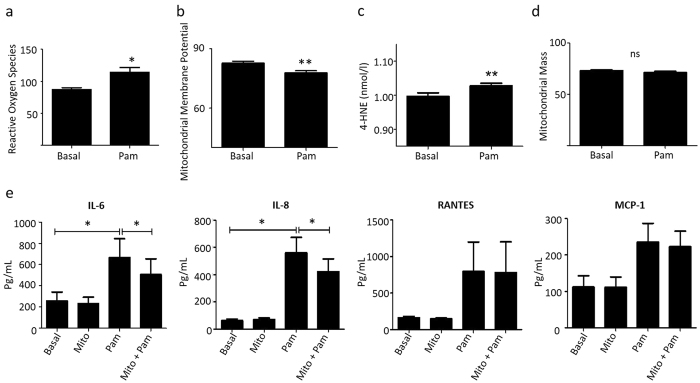
TLR2 activation induces mitochondrial dysfunction in RASFC in vitro.(a) Representative bar graphs demonstrating the effects of Pam3CSK4 (1 μg/ml) stimulation (24 hrs) on reactive oxygen species (ROS), (b) mitochondrial membrane potential (MMP), (c) 4-hydroxynonenal (4-HNE) and (d) mitochondrial mass (all n = 8). (e) Representative bar graphs demonstrating IL-6, IL-8, RANTES and MCP-1 secretion from RASFC following Pam3CSK4 (1 μg/ml) stimulation in the presence or absence of ROS scavenger MitoTEMPO (10 μM) (24 hrs) (n = 5). Data was analysed using Wilcoxin Signed Rank test and is represented as Mean ± SEM, *p < 0.05, **p < 0.01 significantly different to control.